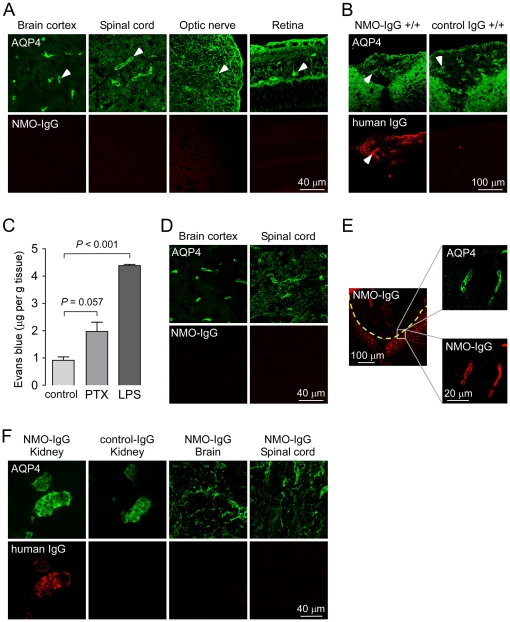
NMO-IgG localization in AQP4-expressing cells in the central nervous system following intravenous administration.A. Confocal fluorescence images for studies as in Fig. 3, showing AQP4 (green) and NMO-IgG (red) in retina, optic nerve, spinal cord and brain. B. Binding of NMO-IgG in the area postrema in brain. C. Evans blue quantification in brain of control mice and mice treated with pertussis toxin (PTX) or LPS (mean±S.E., 4 mice per group). D. Confocal fluorescence images showing AQP4 (green) and NMO-IgG (red) in brain and spinal cord of mice treated with LPS. E. Intravenously injected NMO-IgG enters brain parenchyma near the site of mechanical injury (dashed line, left panel) and binds to AQP4 on astrocyte end-feet around blood vessels (right panels). Data are representative of 4 mice. F. Pregnant mice (3 mice) were injected intravenously with NMO-IgG or control IgG. After 24 hours, embryos were fixed and stained for AQP4 (green) and NMO-IgG or control IgG (anti-human antibody, red).